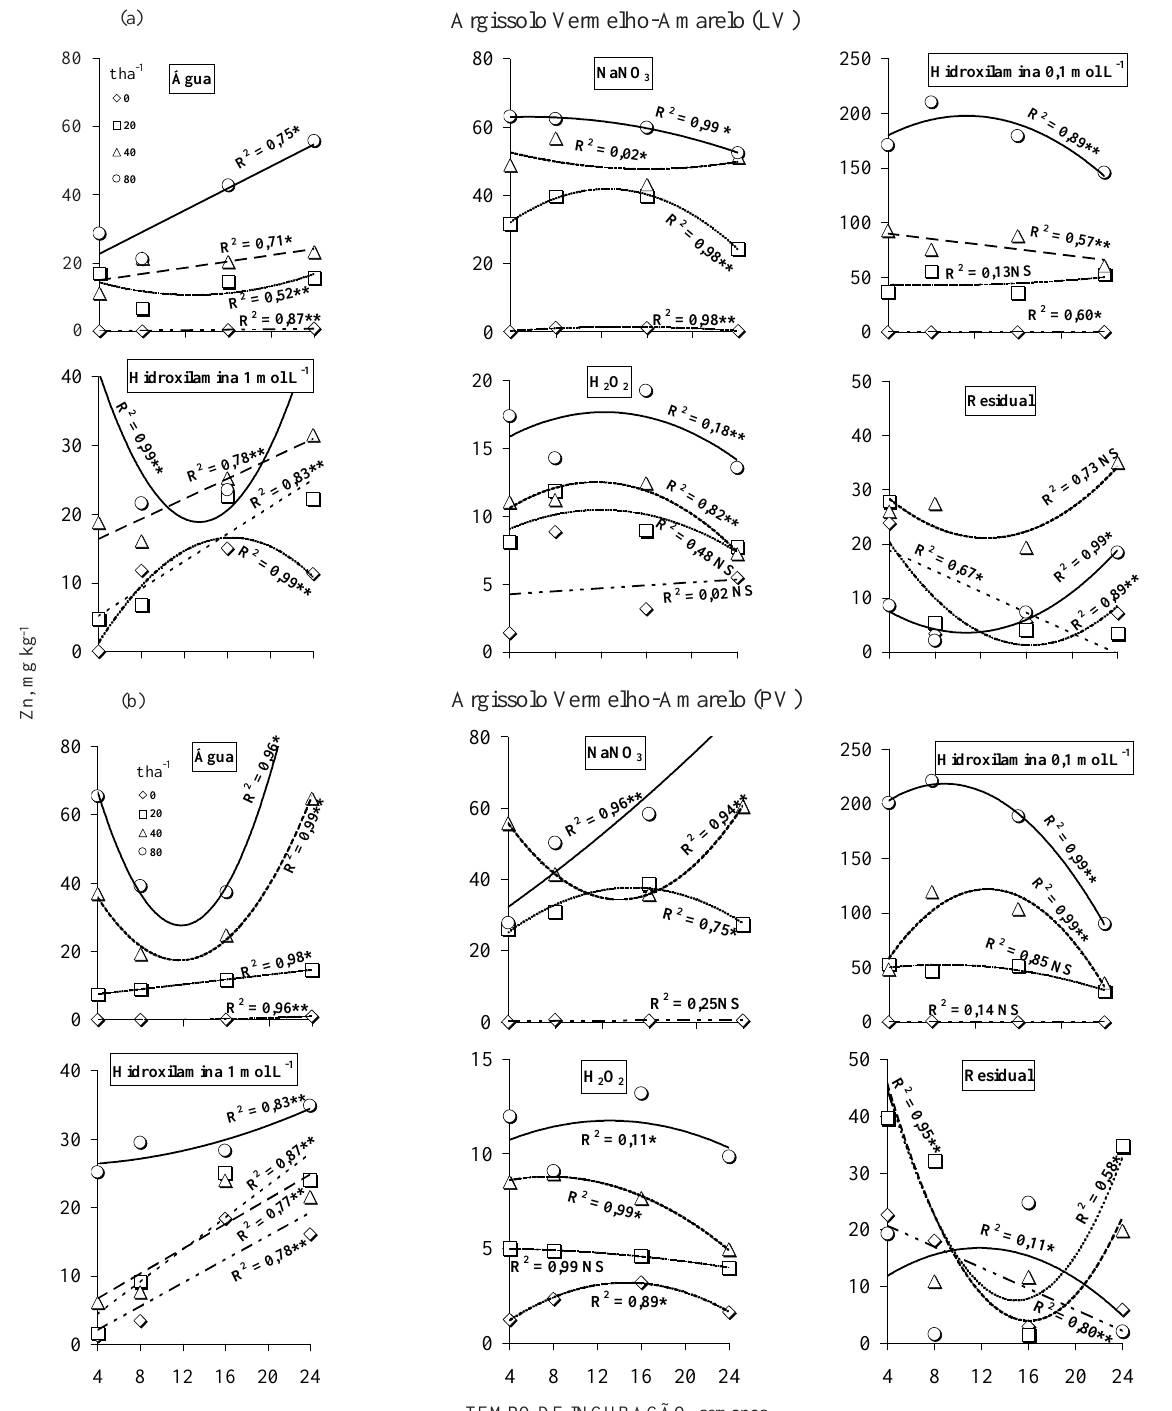
Figura 4. Efeito de tempo de incubação e dose de lodo de esgoto na extração seqüencial de Zn nos solos LV(a) e